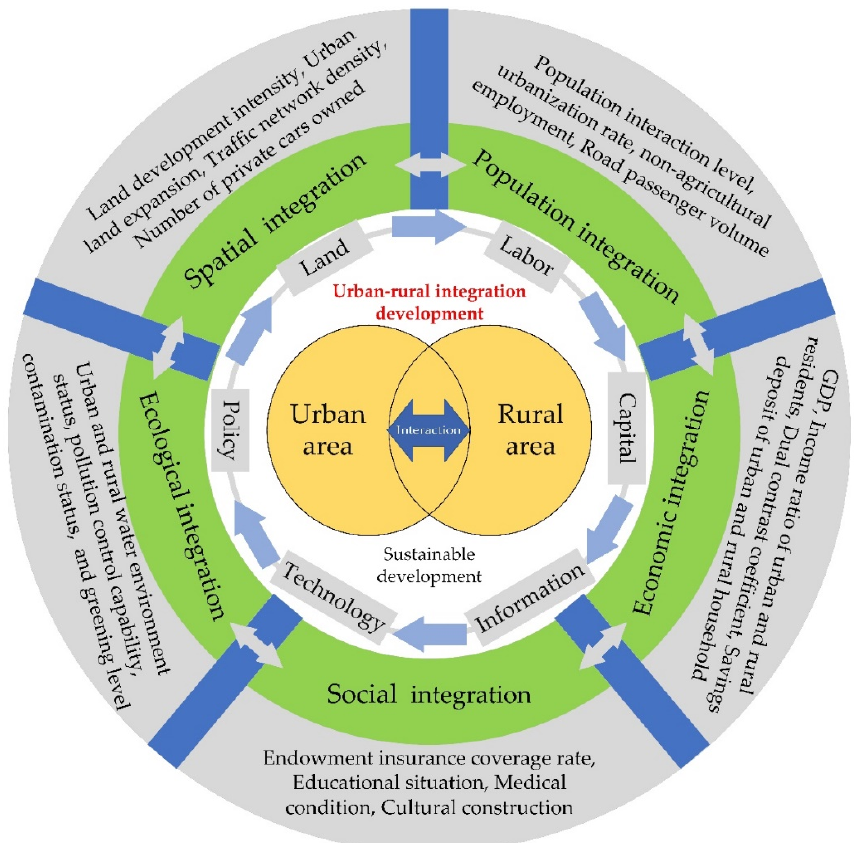
Figure 1. The theoretical framework of URID. GDP represents the gross domestic product.